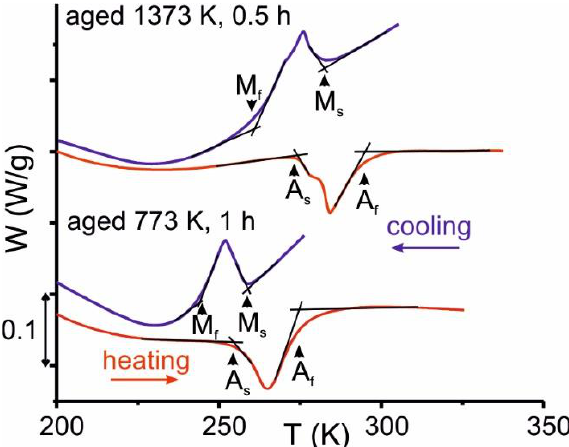
Figure 3. DSC curves for aged [001]-oriented Ni 54 Fe 19 Ga 27 single crystals. Table 1. Characteristic parameters of MT and heat characteristics from DSC response for [001]-single crystals Ni 54 Fe 19 Ga 27.